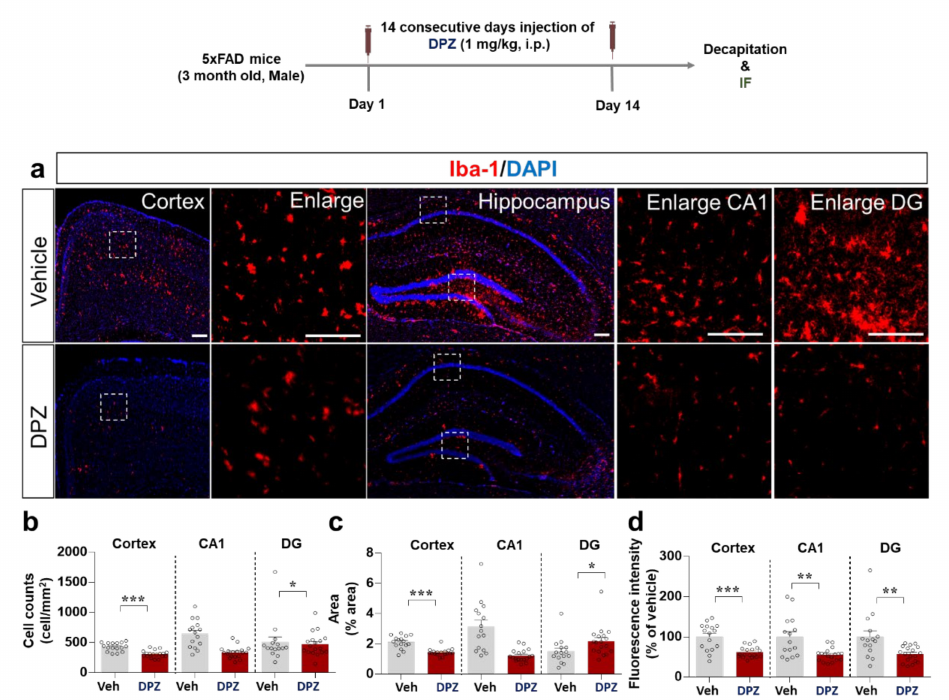
Figure 8. Donepezil suppresses A β -mediated microgliosis and hypertrophy in a mouse model of AD. ( a ) Immunostaining of Iba-1 in brain sections from 5xFAD mice treated as shown with anti-Iba-1. ( b – d ) Quantification of the results in ( a ) ( n = 15–18 brain slices from 4 mice/group). * p < 0.05, ** p < 0.01, *** p <